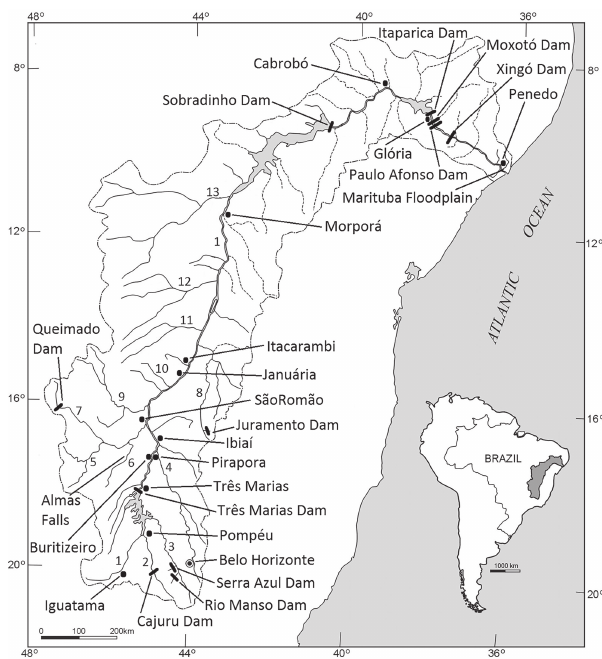
Fig. 2. Map of São Francisco River basin showing major rivers and all municipalities and dams cited in the text. (1 = São Francisco River, 2 = Pará River, 3 = Paraopeba River, 4 = Velhas River, 5 = Paracatu River, 6 = Sono River, 7 = Preto River, 8 = Verde Grande River, 9 = Urucuia River, 10 = Pandeiros River, 11 = Carinhanha River, 12 = Corrente River, and 13 = Grande